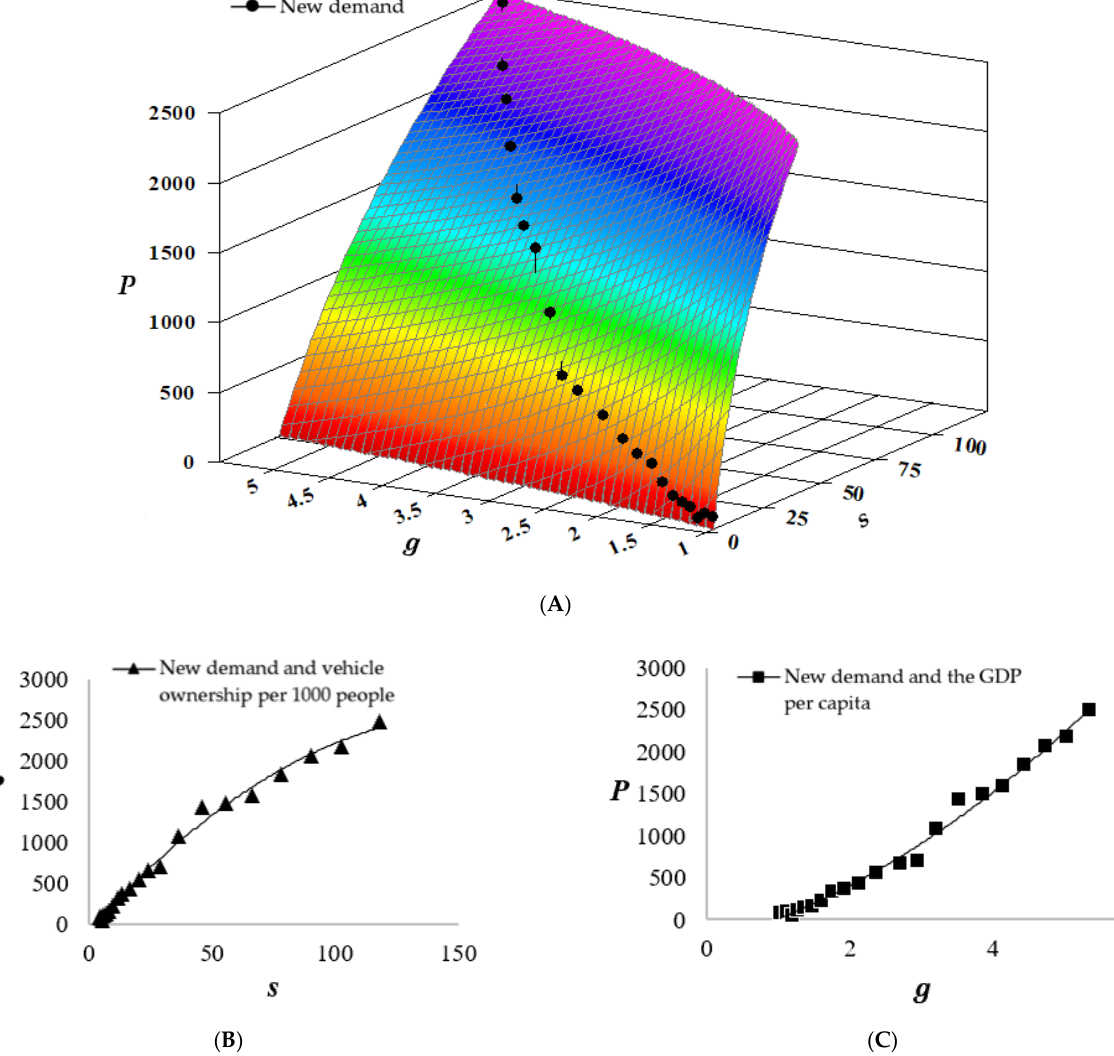
Figure 2. Estimation of the demand for new passenger vehicles ( A ). The relationship between P and s ( B ). The relationship between P and g ( C ). The unit of P (estimated demand for new passenger vehicles) is 10 4 vehicles; the unit of s (estimated passenger vehicle ownership per 1000 people) is vehicles/1000 people; and the unit of g (GDP per capita at constant prices) is 10 4